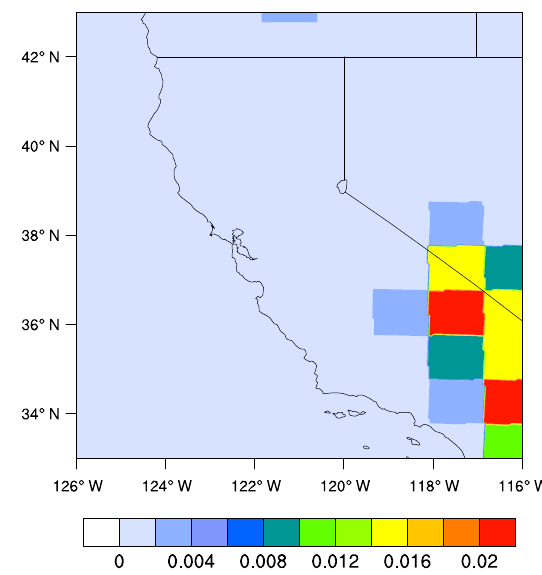
Figure 9. Fraction of erodible surface in the GOCART dataset used in this